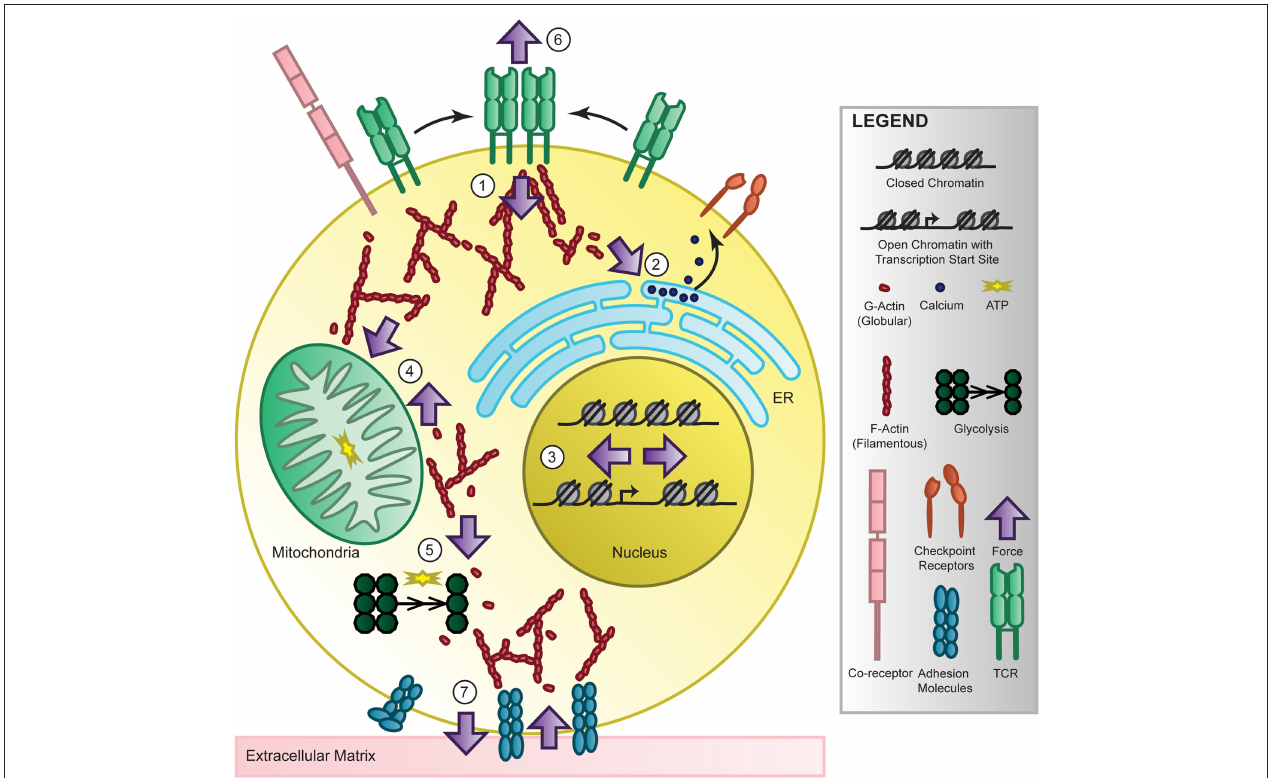
FIGURE 3 | T-cell mechanotransduction. T cells perceive environmental force cues such as ligand binding, substrate stiffness, and shear stress through their surface receptors and membrane structure. These forces are internalized and transmitted at the cytoplasmic side of the receptors (1) and by the cytoskeleton, converted into biochemical signaling, then propagated to organelles such as the endoplasmic reticulum (ER) where calcium is released (2), the nucleus where the chromatin landscape and transcription changes (3), the mitochondria (4) or cytoskeletal-bound glycolytic compartments (5) to change energy production or back out to the surface of the T cell at the immunological synapse (6) or extracellular matrix (7) to modulate adhesion and cytokine release. Though accumulating evidence links force to T cell recognition, signaling, differentiation, metabolism, and genetics in T cells and others, the mechanisms require further study. However, energy-dependent cytoskeletal rearrangement is most likely the key to providing future investigators direction for uncovering the molecular players of T-cell mechanotransduction and elucidating force-dependent